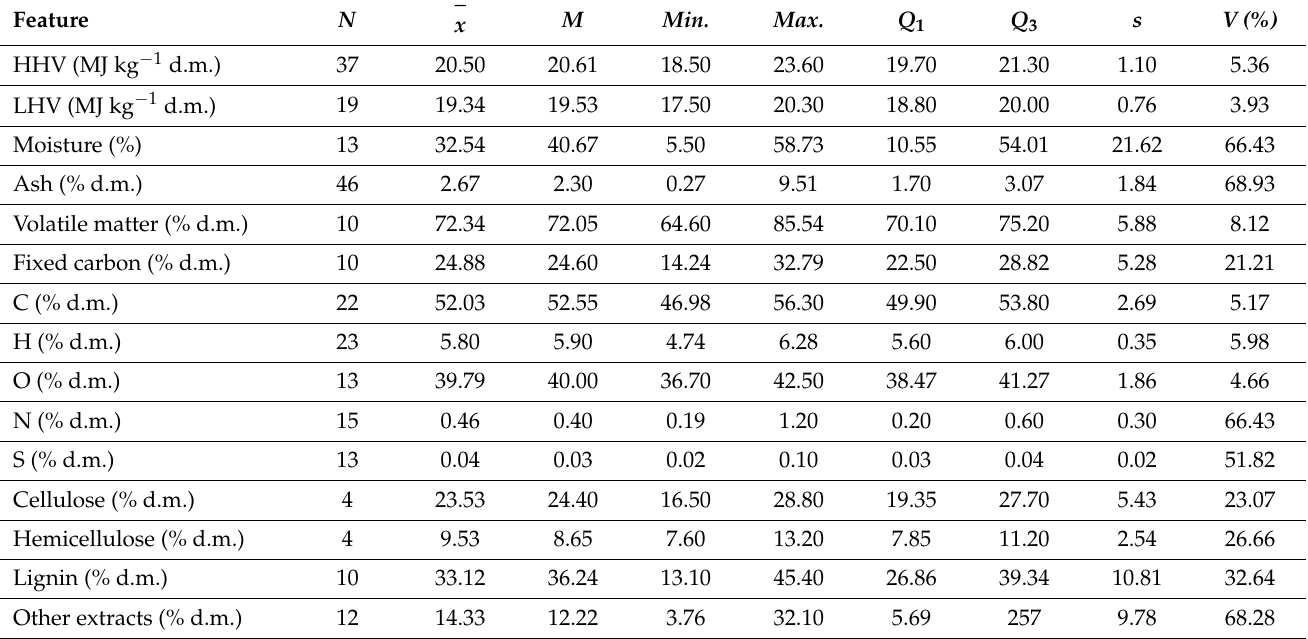
Table 8. Differentiation of thermophysical properties and elemental composition of coniferous